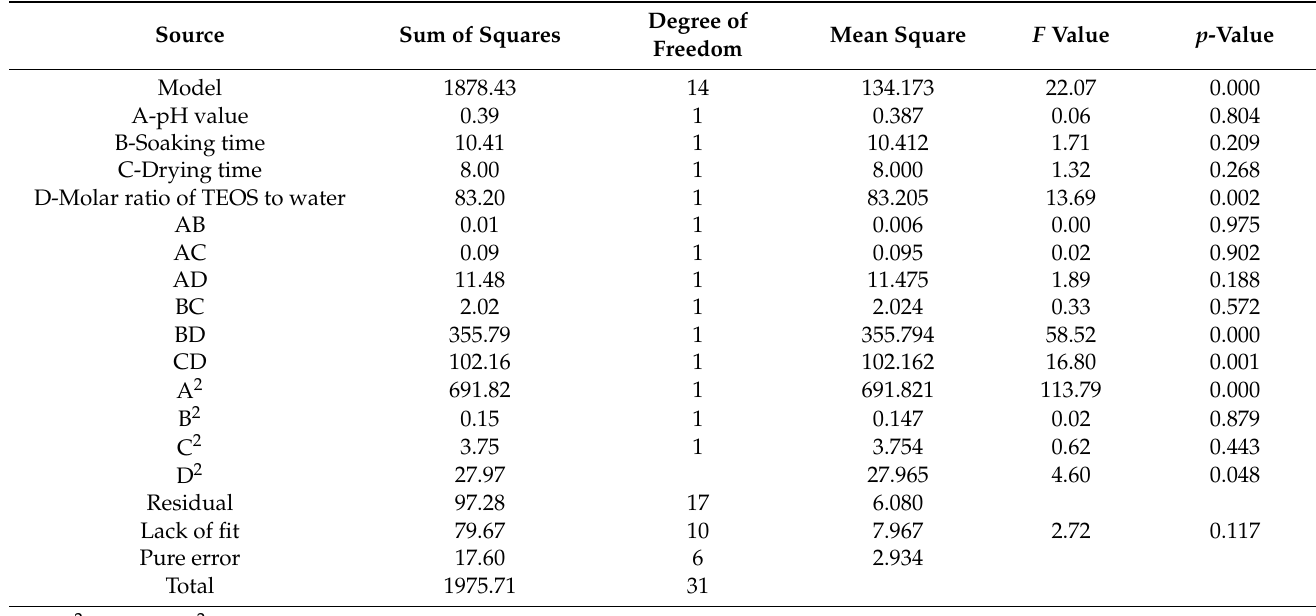
Table 5. Analysis of variance (ANOVA) for the percentage silica residue from thermogravimetric analysis. Degree Source Sum of Squares